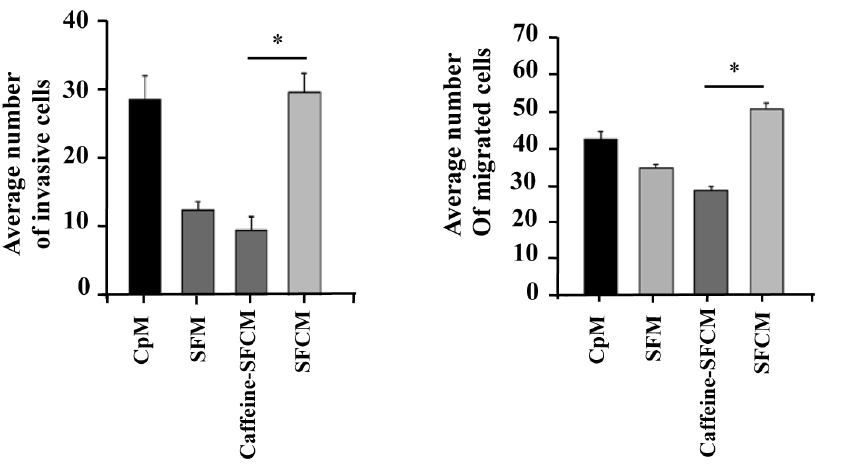
Figure 4. Caffeine inhibits MDA-MB-231 invasion/migration in a paracrine manner. Serum-free conditioned media were collected from CAF-180 cells either sham-treated or challenged with caffeine (0.2 mM, for 1 hr), SFM as well as complete media (CpM) were also used as control. These media were added separately into the lower compartments of the 24-well BD BioCoat plates. MDA-MB-231 cells (1 6 10 4 ) were seeded onto the upper compartment of the migration (non-coated chambers) and invasion (Matrigel Invasion Chamber) plates and incubated for 18 hr. Average numbers of migrated/invaded cells were depicted in the histograms. Error bars represent means 6 S.D. *: p , 0.05.